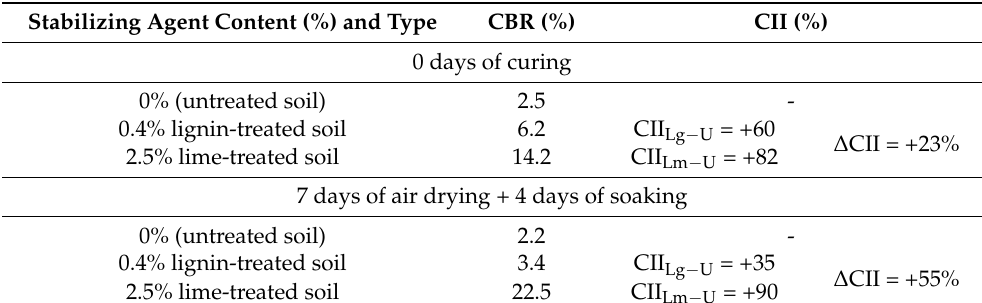
Table 6. Comparison between the results of the CBR test carried out on the untreated soil, the lignin-treated soil, and the soil treated with